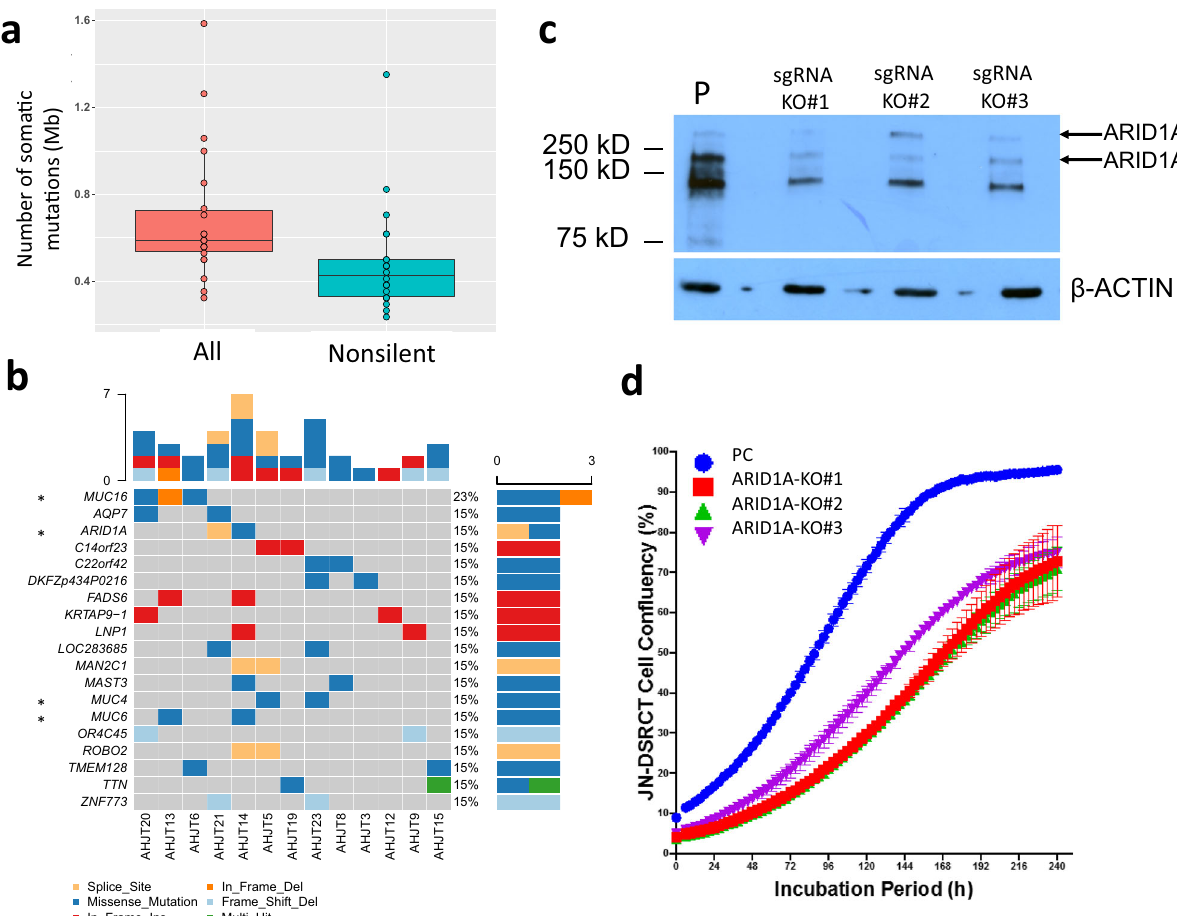
Fig. 1 Mutation analysis. a Point mutation rate (number of mutations per Mb) in our DSRCT specimens. Boxplots show center line as the median, box limits as upper and lower quartiles of the mutation rates. b Landscape of recurrently mutated genes. Genes are shown according to patient, not specimen, so mutations in different specimens from the same patient are shown in the same column. Genes that are known to be associated with cancer are marked with “ * ” . The cancer gene annotations were compiled from the Sanger Cancer Gene Census in COSMIC. c Western blot demonstrating CRISPR/CAS9-mediated knockout of ARID1A using three different guide sgRNAs (KO#1, KO#2, KO#3) in JN- DSRCT. β -actin is used as a loading control. PC — parental line as a control. All blots derived from the same experiment and were processed in parallel. d Time course for the effect of ARID1A knockout results in signi fi cantly reduced proliferation (Con fl uence (%) is presented as the mean SD, n = 3 wells). Boxplots show center line as the median, box limits as upper and lower quartiles of the data. The source data of this fi gure is provided in the Source Data fi